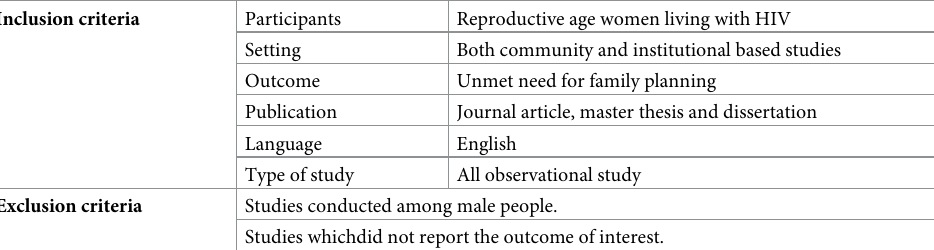
Table 1. Eligibility criteria’s for studies include in meta-analysis of unmet need for family planning among repro- ductive-age women living with HIV in Ethiopia. Inclusion criteria